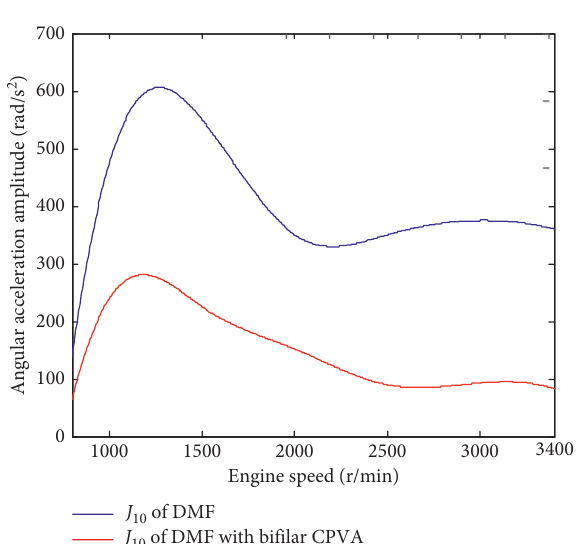
Figure 40: Comparison of the 2 nd order angular acceleration amplitudes of J